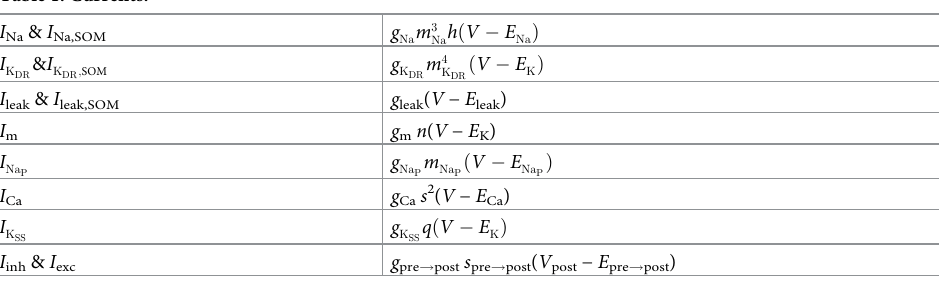
Table 1. Currents.